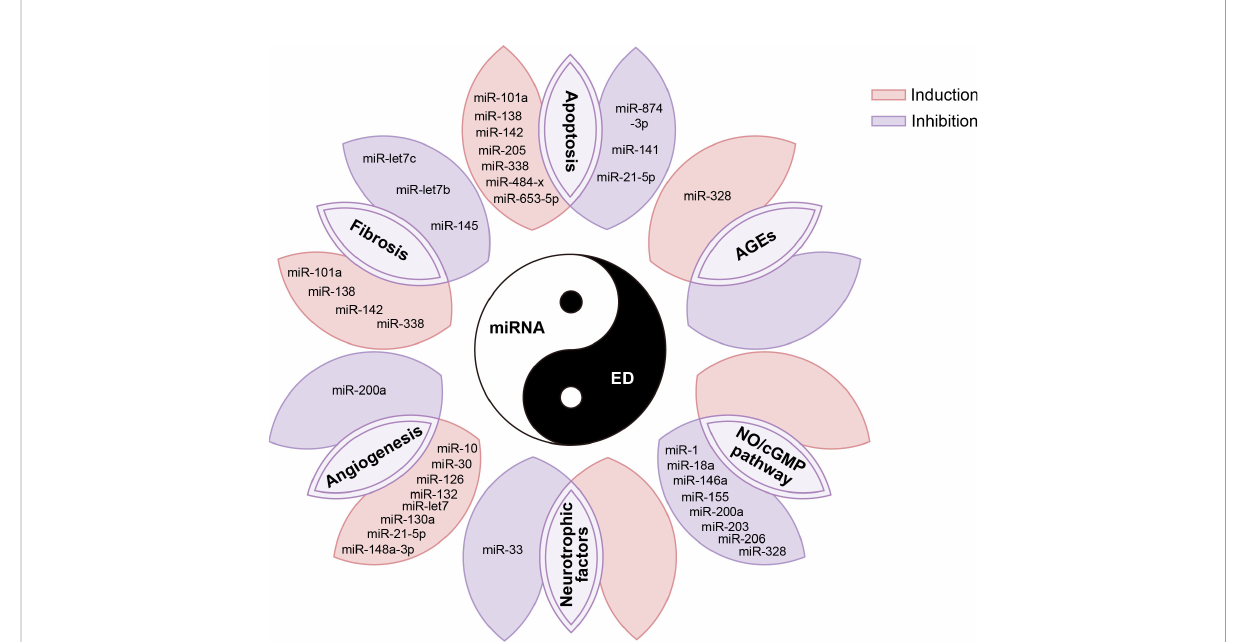
FIGURE 3 miRNAs are involved in various pathophysiological processes in the occurrence and development of ED. AGE, advanced glycation end products; NO, nitric oxide; cGMP, cyclic guanylate